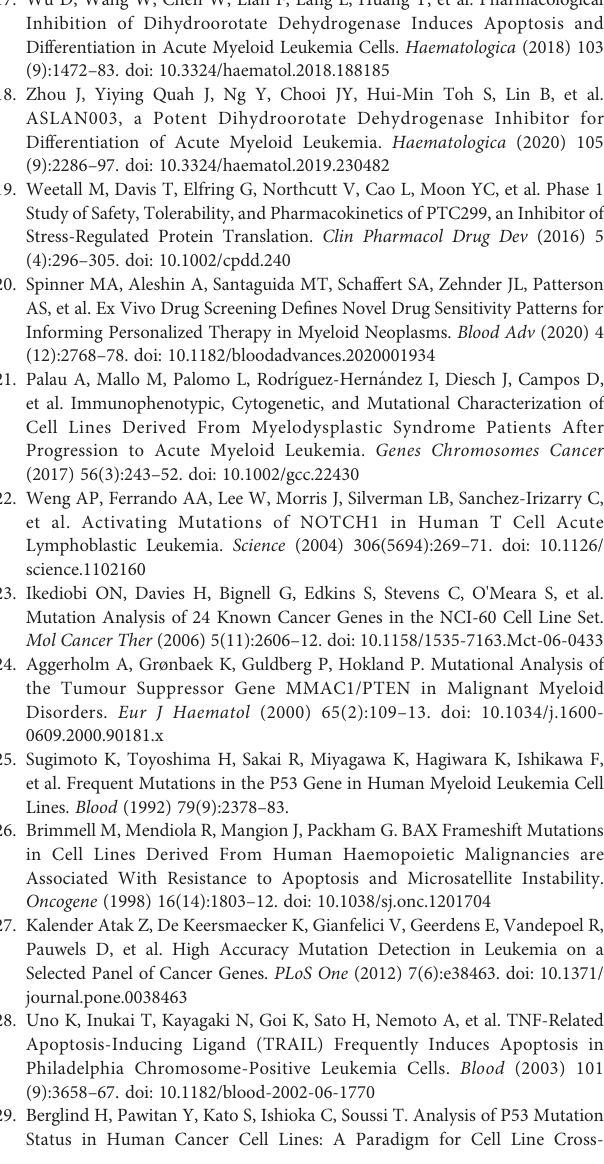
Supplementary Figure 5 | Mice bearing MOLM-13 tumors were dosed with PTC-868 and at each timepoint, 3 mice per group were euthanized. Values represent the mean ± SEM. (A) Inhibition of MOLM 13 tumor growth with treatment ofPTC-868(1mg/kg,PO).Valuesrepresentthemean±SEMforN=10mice/group. quanti fi cation. Supplementary Figure 6 | After a single dose of emvododstat, blood was obtained at speci fi ed timepoints and processed to plasma. Plasma was analyzed for levels of emvododstat, DHO, and uridine. The blue line shows levels emvododstat, the orange line shows the levels of